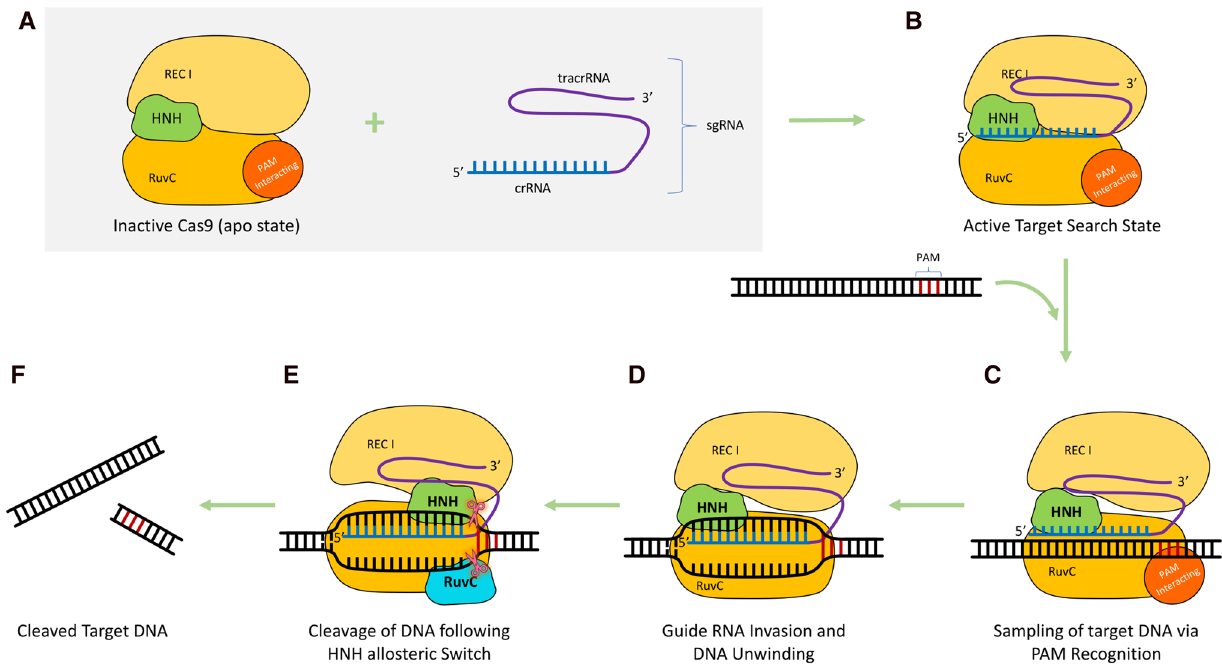
Fig. 2 Molecular mechanism of CRISPR/Cas9